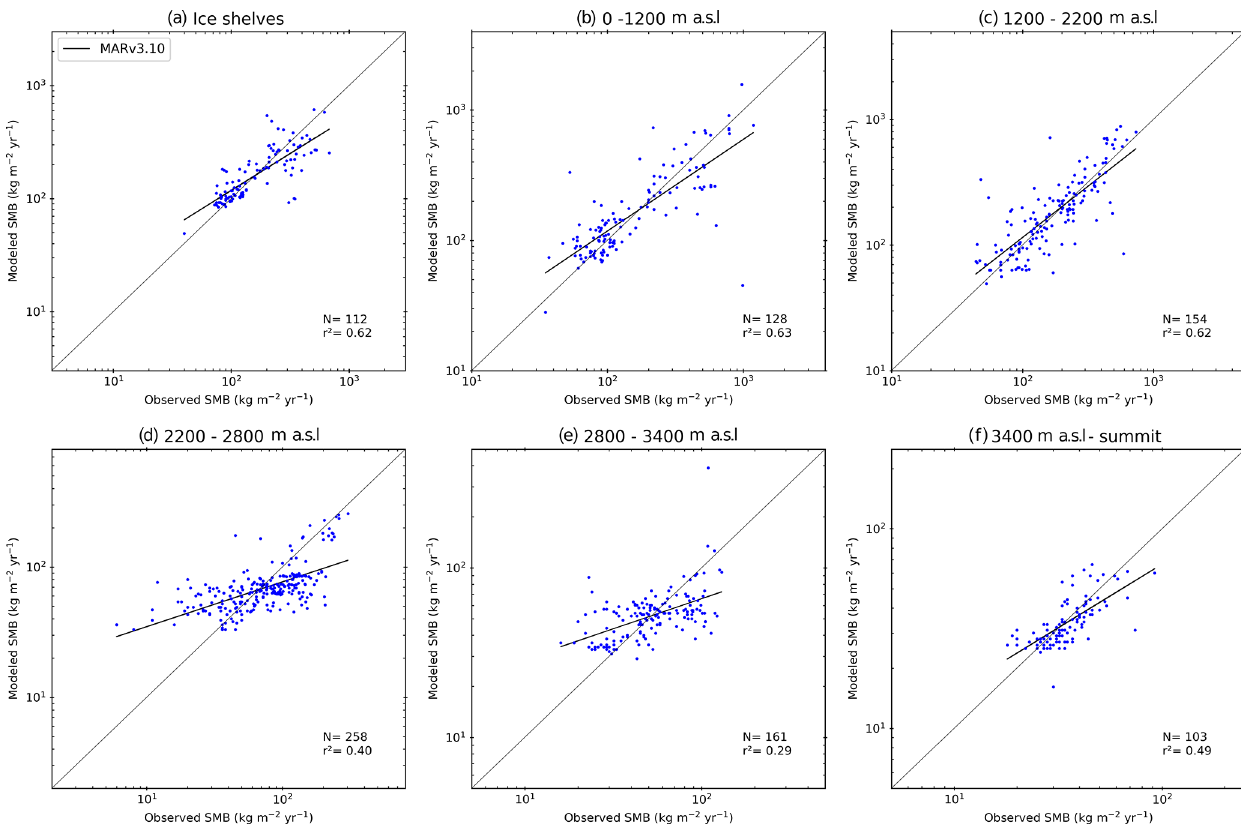
Figure A6. Comparison between MAR v3.10 and observed SMB (units: kgm − 2 yr − 1 ) over the ice shelves (a) and by elevation classes (b–f) . Due to the use of logarithmic axes, only positive values for the observed and modelled SMB from all the RCMs in this study are used (number for each bin N ). Finally, the regression coefficient of each regression line is also shown ( r 2